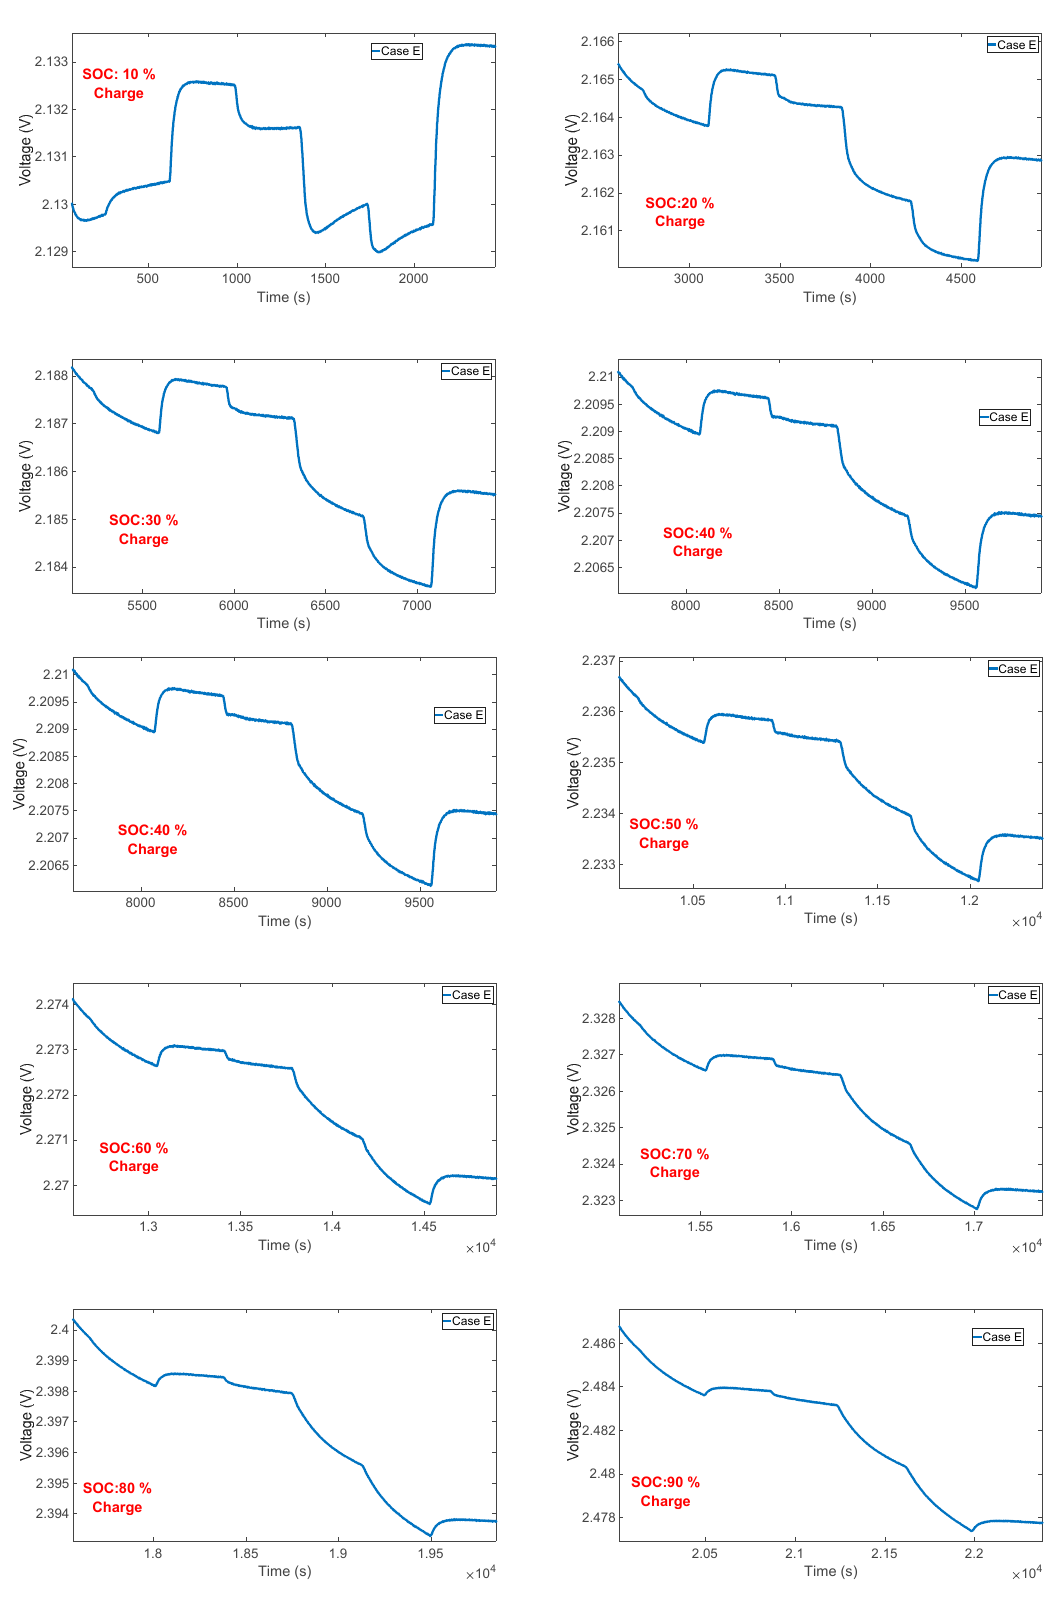
Figure 4. Voltage variations during case E at various SOC. Table 2. Entropic heat coefficient (EHC) (mV/°C) at different state of charge (SOC) and cases.